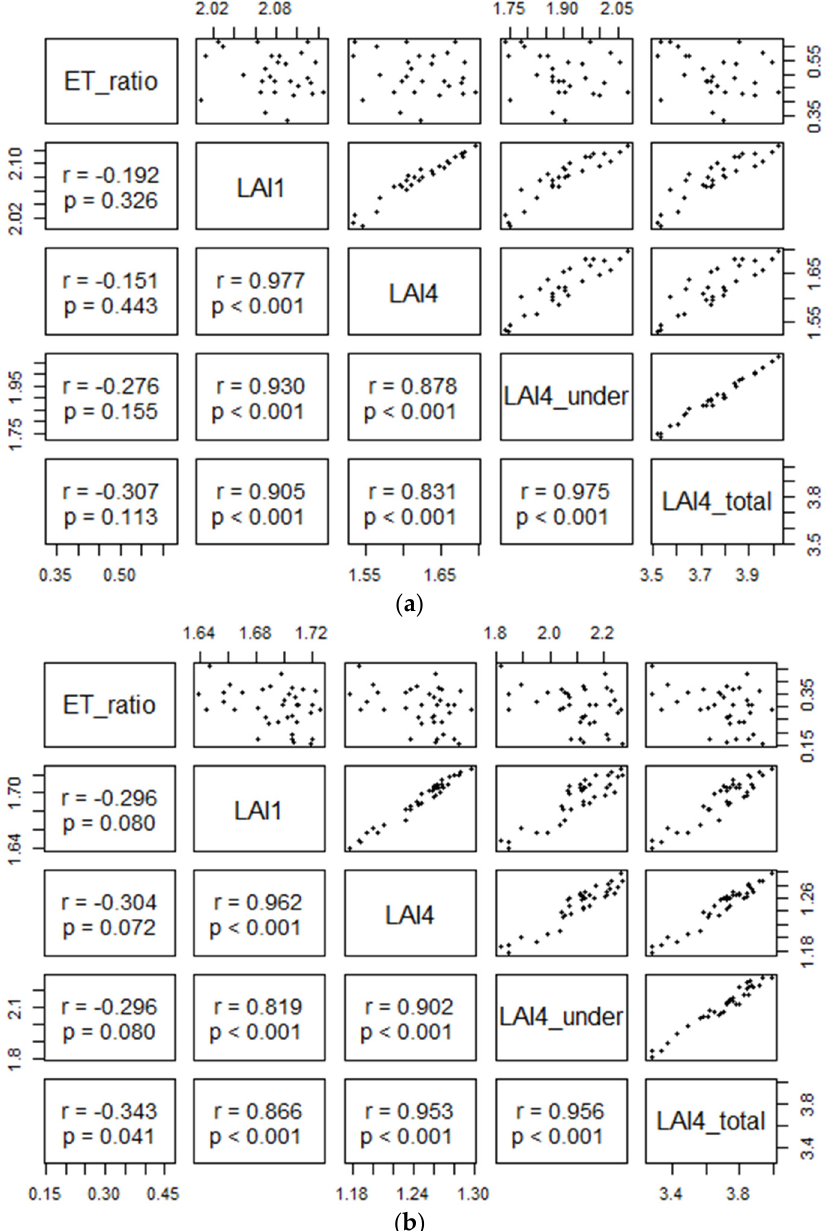
Figure 7. Comparisons of annual ET ratio and watershed-scale median leaf area index for two watersheds: ( a ) South Fork Flathead River and ( b ) Middle Fork Flathead River, as estimated using methods LAI1 and LAI4 (overstory), LAI4under (understory) and LAI4total (total LAI) for water years 1984–2019. ET ratio is defined as 1 minus the ratio of mean annual streamflow to mean annual precipitation. R represents the Spearman’s rank correlation coefficient.